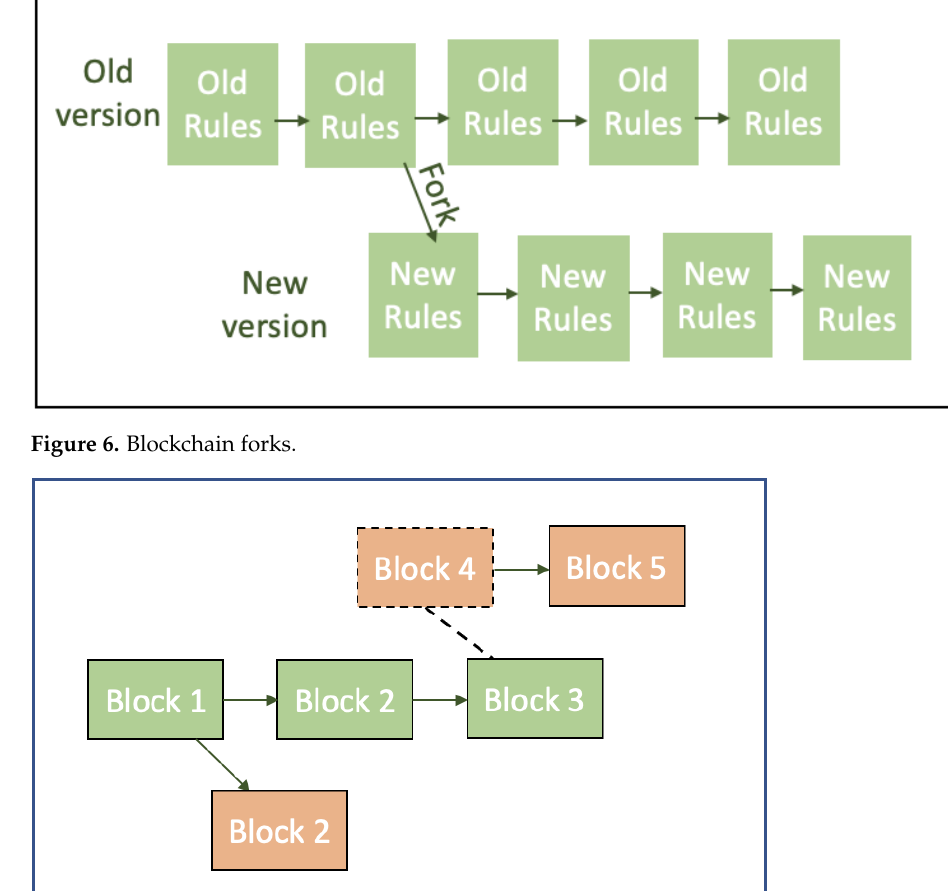
Figure 7. Stale blocks and orphaned